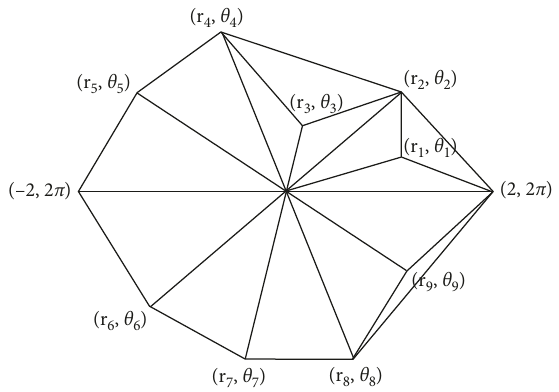
Figure 4: Irregular shape modelling for